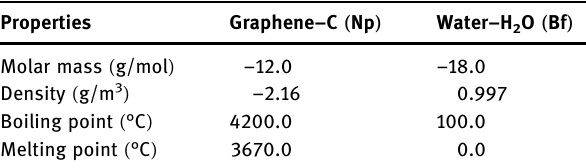
Table 1: Base fl uid and nanoparticle pro fi le table [ 33,52 ]